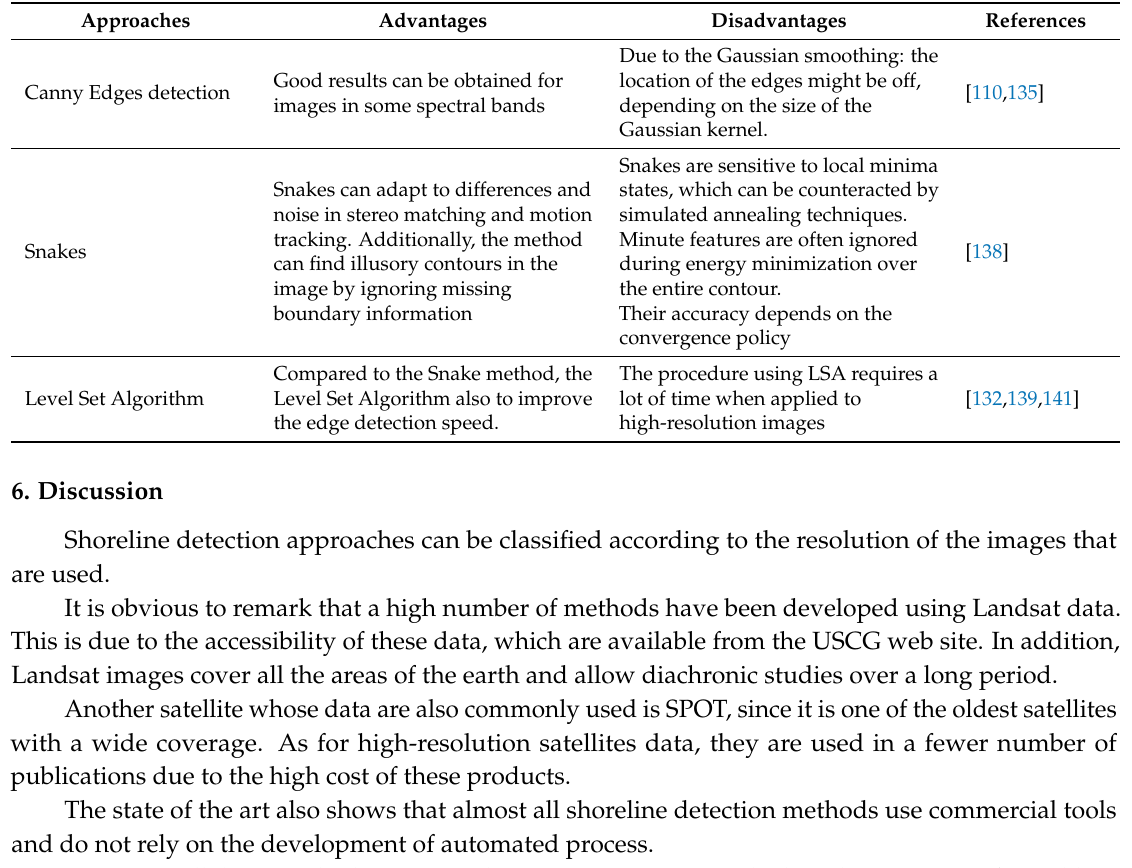
Table 7. Summary of edge detection